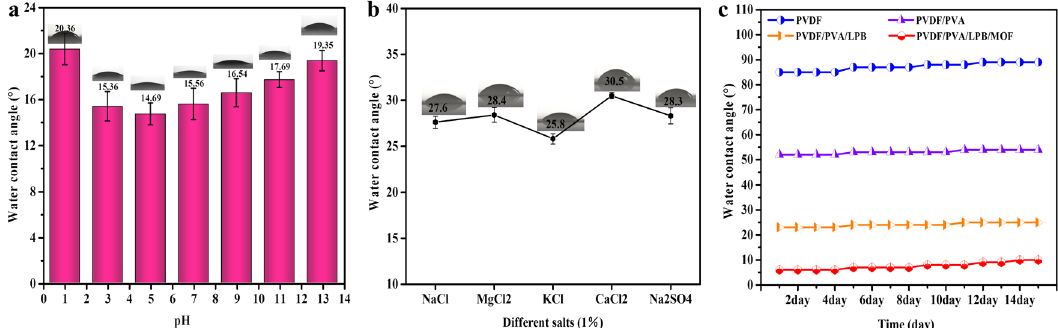
Fig. 7 Environmental stability of different composite fi lms. a The water contact angle (WCA) after PVDF/PVA/LPB/MOF membranes is soaked under different pH conditions (s.d.). b WCA of PVDF/PVA/LPB/MOF membrane after immersion in different salt solutions (s.d.). c WCA of different mixed membranes placed for different days.